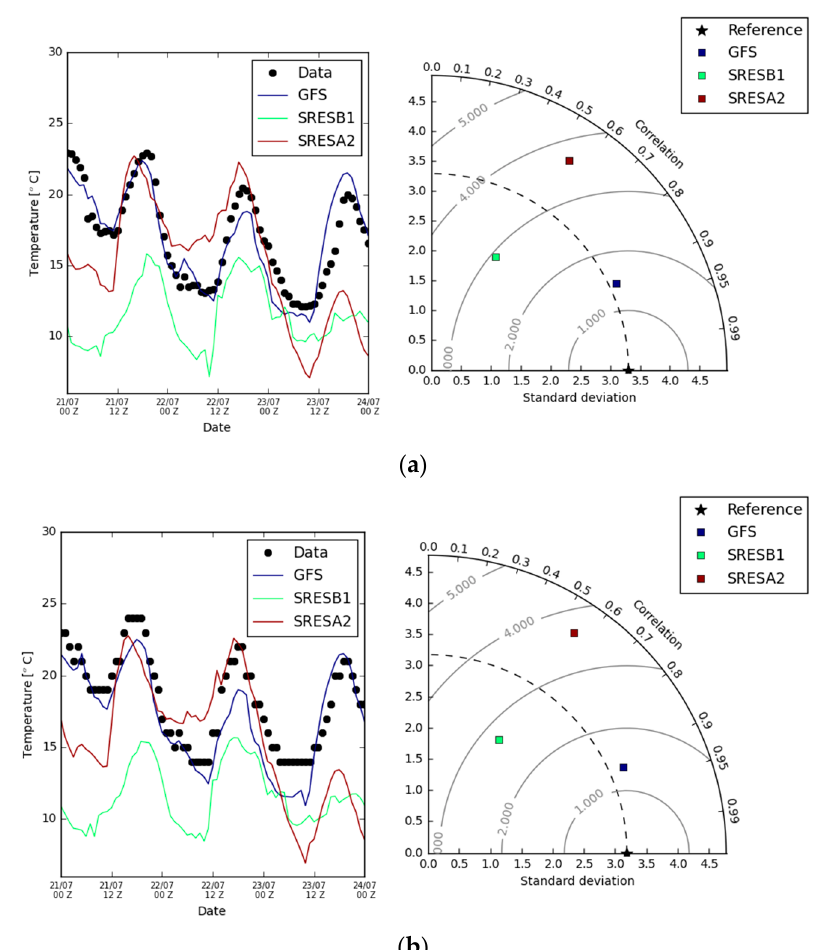
Figure 4. Evolution of temperature (left column) and Taylor diagram (right column) for ( a ) SIMEPAR and ( b ) Londrina Airport METAR data stations. Blue line is the simulation with GFS as input and boundary conditions, green line is the simulation with B1 scenario and red line is the simulation with A2 scenario. Both are output from CCSM3